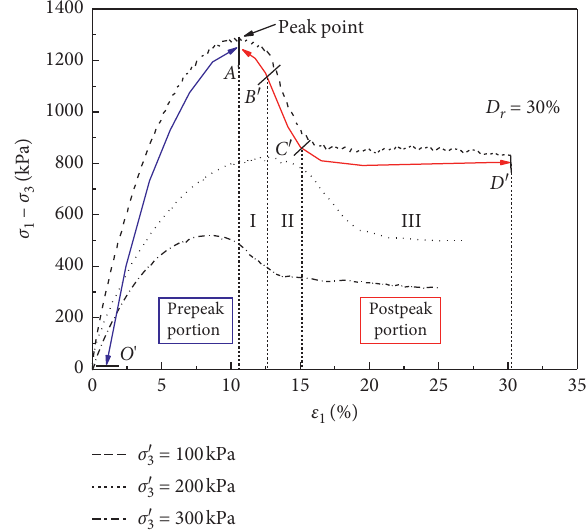
Figure 5: Stress-strain curves of dry calcareous sand at different confining